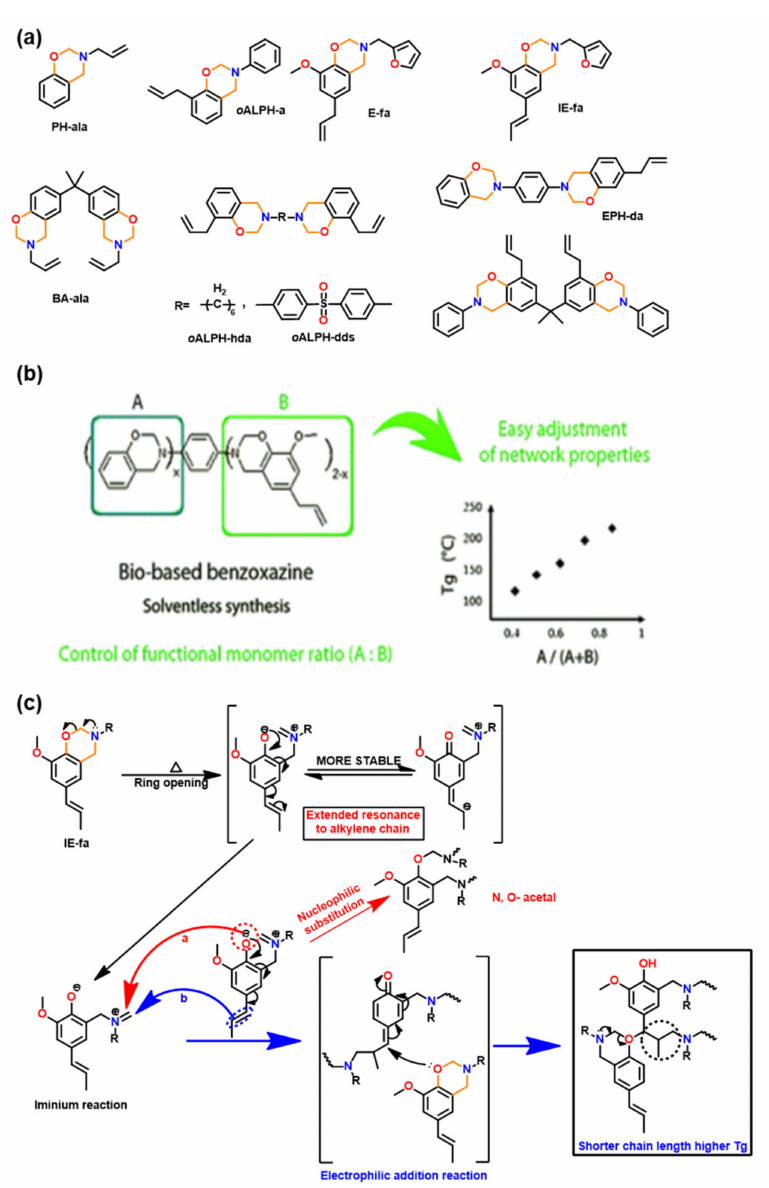
Figure 17. ( a ) Structures of allyl-functional benzoxazines [53,95,204–206]. ( b ) Strategy to affect T g using hybrid bio-based monomer [94]. Copyright 2015. Reproduced with permission from Royal Society of Chemistry. ( c ) Probable mechanism of ring-opening polymerization in IE-fa Bz monomer